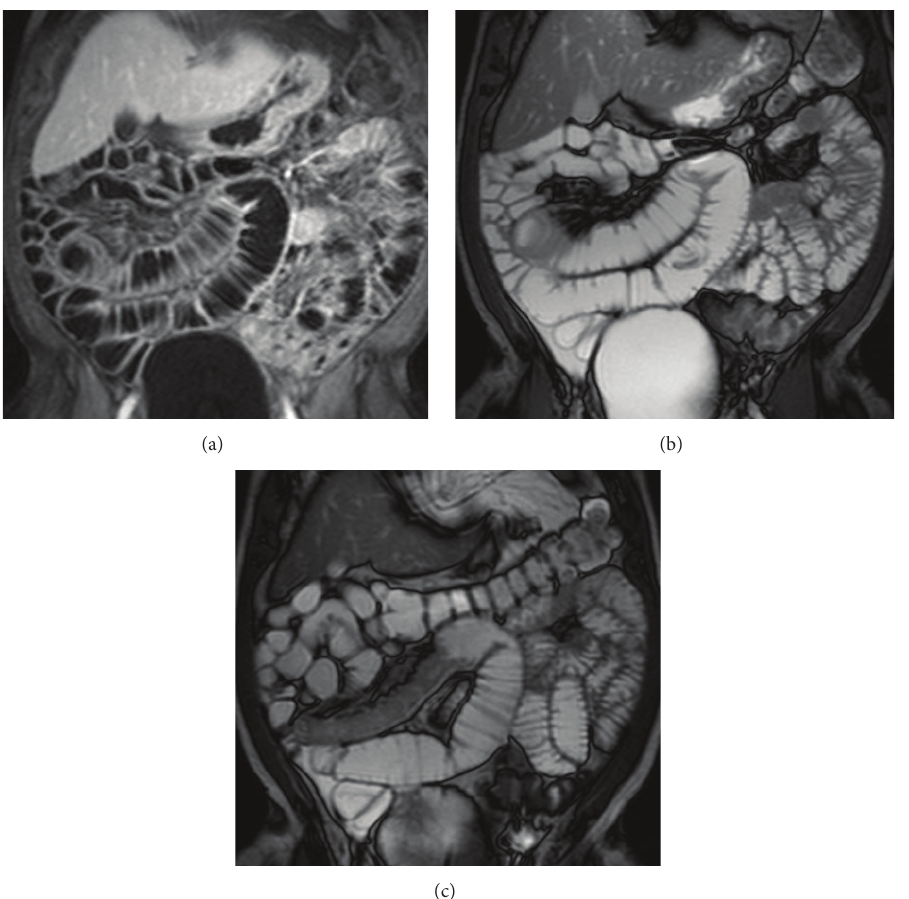
Figure 2: Lesion with nodular aspect protruding into the intestinal lumen with infiltrative growth. A significant desmoplastic reaction and fibrosis of adjacent loop are also present. Definitive histology: neuroendocrine